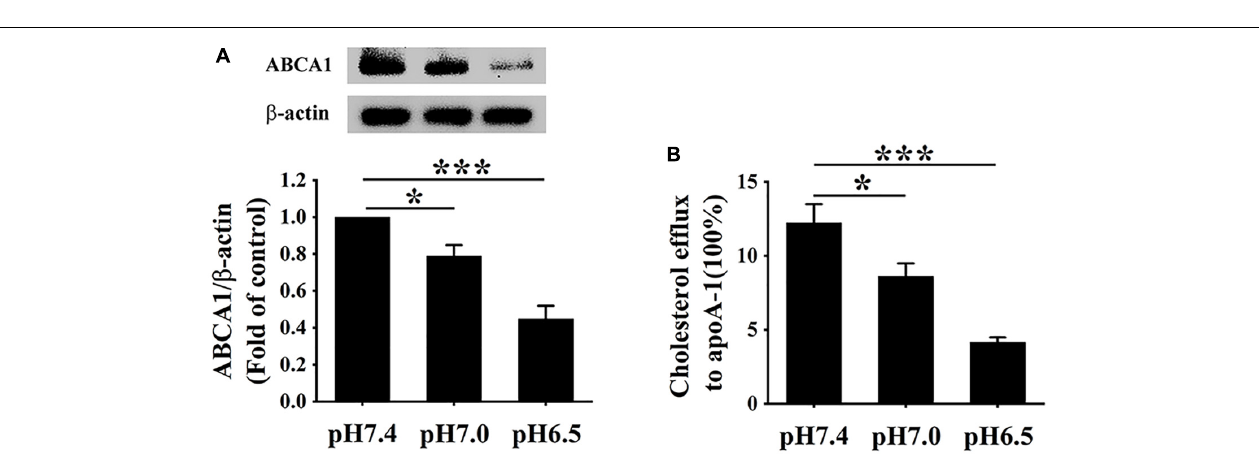
FIGURE 4 | Extracellular acidification decreases ABCA1 protein levels and cholesterol efflux of macrophages. (A) RAW 264.7 cells were incubated in different pH media with 25 µ g/ml ox-LDL for 24 h. The protein levels of ABCA1 were valued using WB analysis. (B) ABCA1-mediated cholesterol efflux was analyzed using an NBD-cholesterol kit. Data were shown as the mean ± SEM from 3 to 4 independent experiments. Statistical analysis was performed by one-way ANOVA. * P < 0.05; *** P <